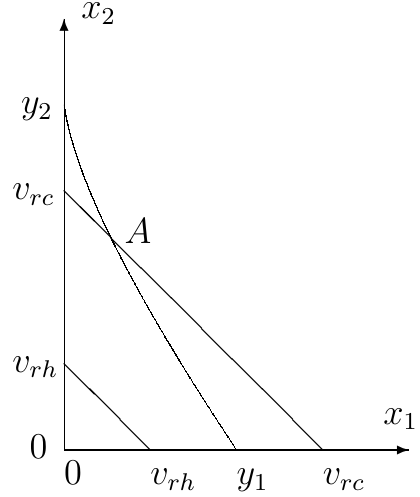
Figure 2. Global attractor for Theorem